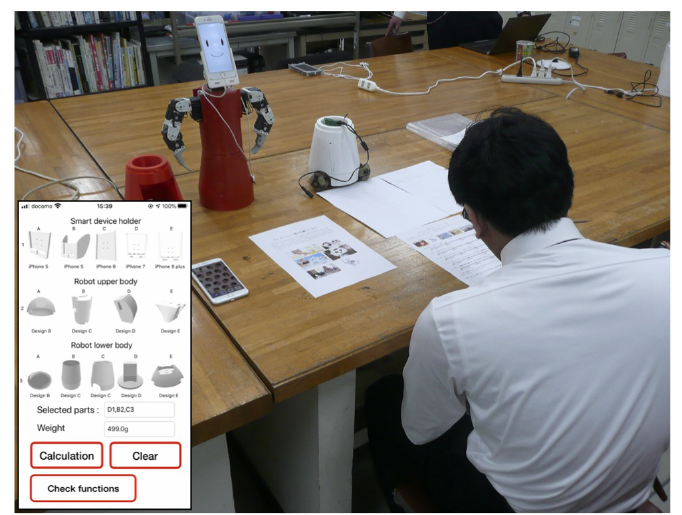
Figure 18. The interview